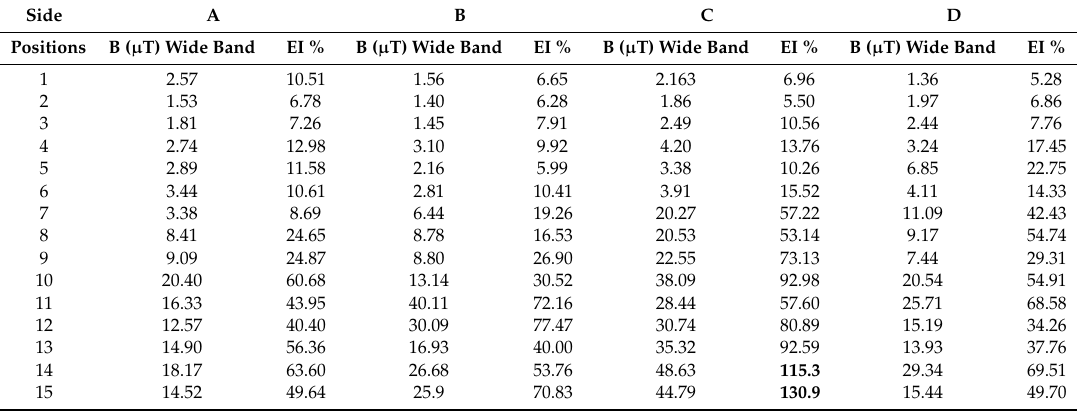
Table 4. B-field and EIs according to the measurement grid for the power unit master, HPCS